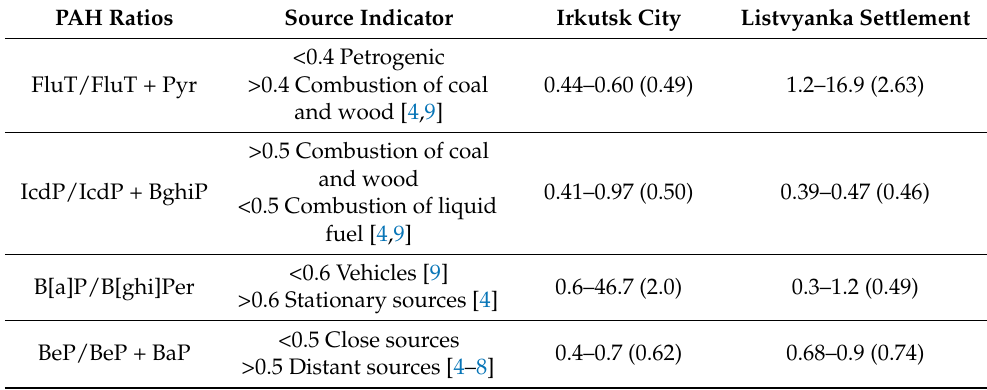
Table 2. Diagnostic indicators of PAHs obtained from 2015 to 2021 in the Southern Baikal